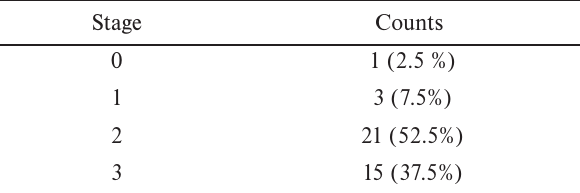
Table 2. Stages of